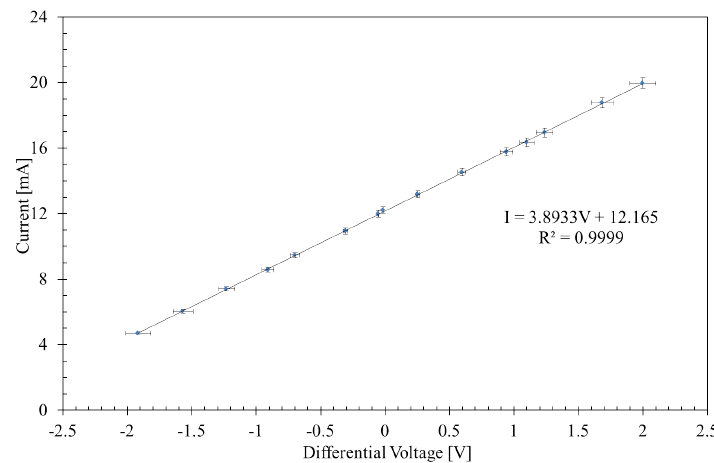
Figure 8. The transfer function of the transconductance amplifier, showing the output current as a function of the measured input voltage difference.